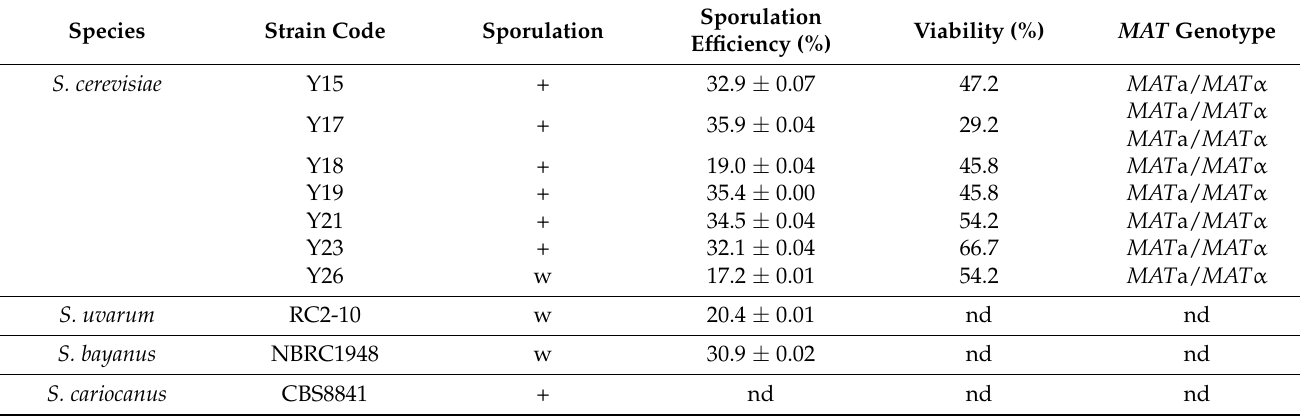
Table 3. Sporulation efficiency, spore viability and MAT genotype. Strains sporulating after 3 and 7 days were scored as + and w (weak), respectively. Sporulation efficiency was determined as the mean of two independent replicates, while viability was calculated considering the dissection of six tetrads for each strain. All values of sporulation efficiency were statistically different based on one-way ANOVA. Abbreviation: nd, not